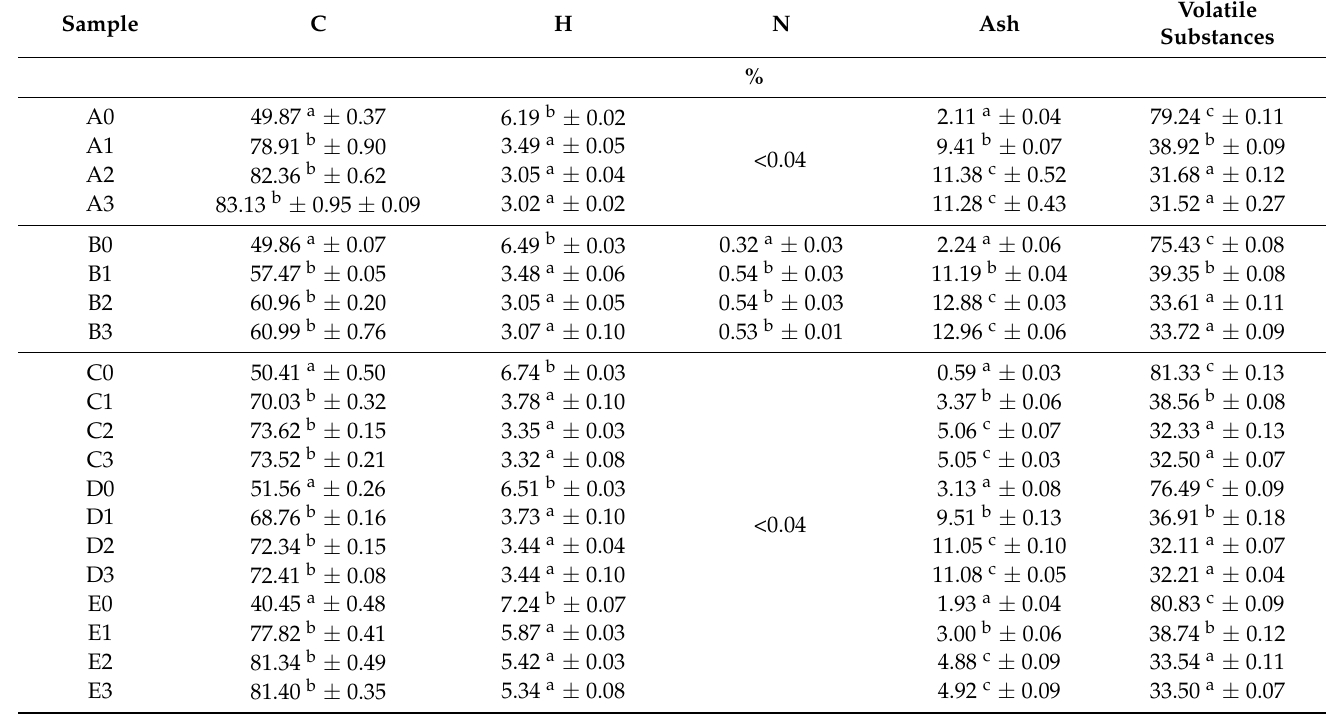
Table 3. Contents of total nitrogen, total carbon, hydrogen, ash, and volatile substances in oak biomass and its